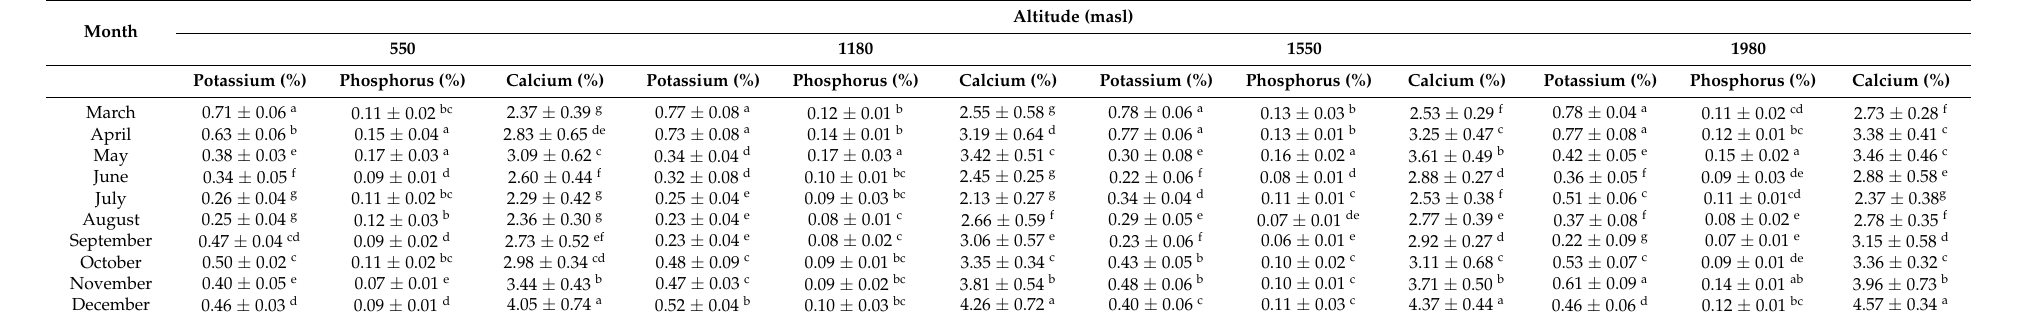
Table A2. Provenance and monthly variation in potassium, phosphorus, and calcium (%) in C. australis foliage ( ± SD). Means followed by the same letter are not significantly ( p < 0.05)